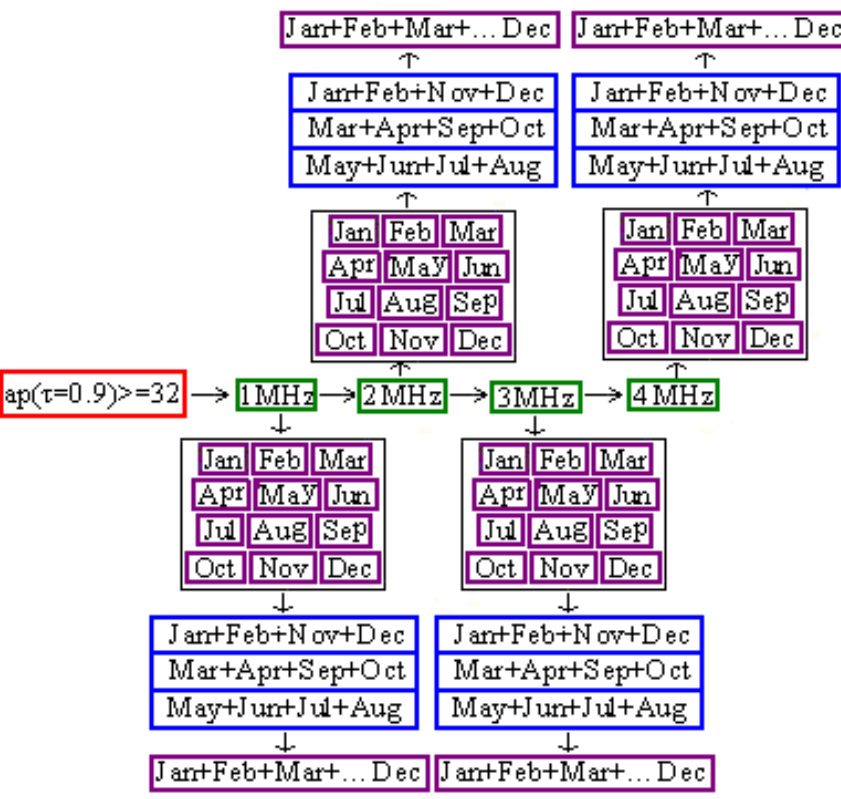
Fig. 6. Scheme followed to select data relative to single months, winter months, equinoctial months, summer months and all the months for the case a p ( τ =0.9) ≥ 32.